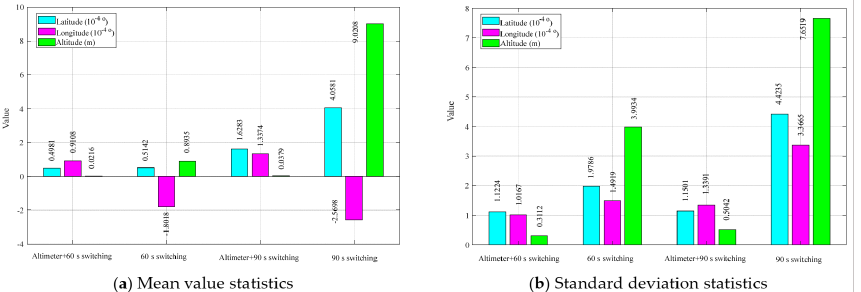
Figure 7. Under the adjacent orbit, the navigation and positioning error statistics of Table 2. Switching + unbiased altimeter algorithm and the INS + LEO2 switching algorithm when the switching times are 60 and 90 s, respectively.